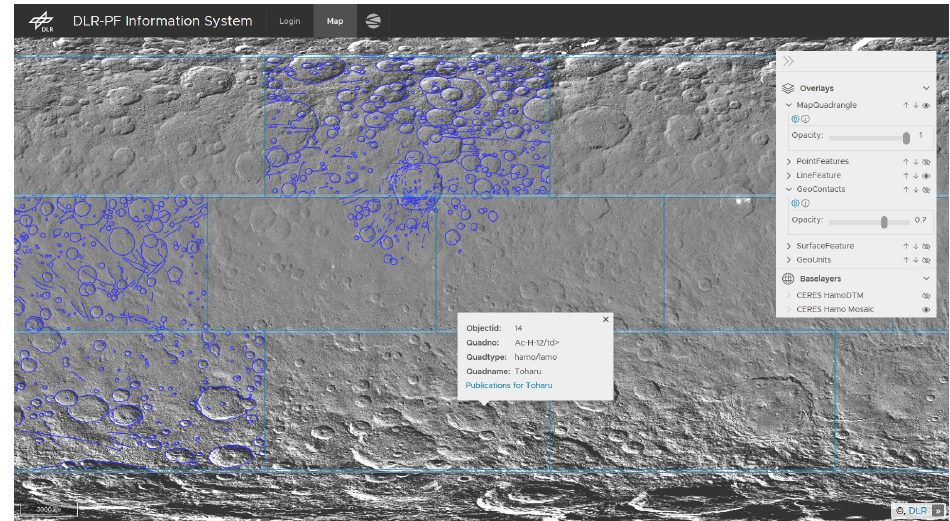
Figure 6. Screenshot of the prototype: Visualisation of sample data from Ceres in a UKIS-based frontend; layer navigation at the right side, attributes of a quadrangle displayed in a pop-up.